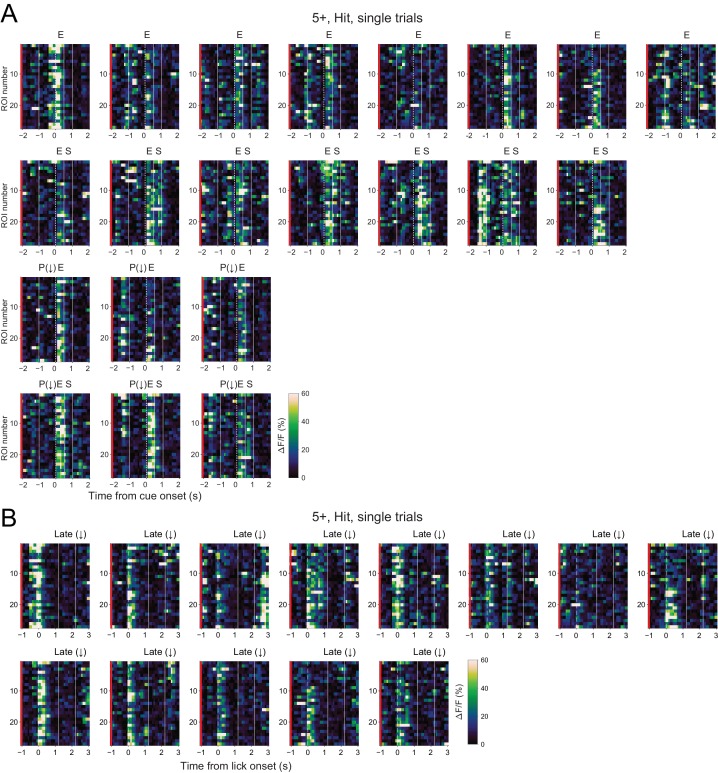
Single ROI single trial CF signals.(A) Single trial calcium traces for single ROI in an example imaging session from a 5+ compartment. Trials detected as pre-cue decreases (P(↓)), early increases (E), and secondary increases (S) in CF signals in the 5+ compartment are indicated on the top. Note the coexistence of these responses in single trials and single ROIs. (B) Same as panels (A) but for late decreases (Late(↓)) in lick aligned traces. Vertical dashed lines represent cue onset, and solid lines represent the edges of response windows. Red bars represent their AldC+ identity.